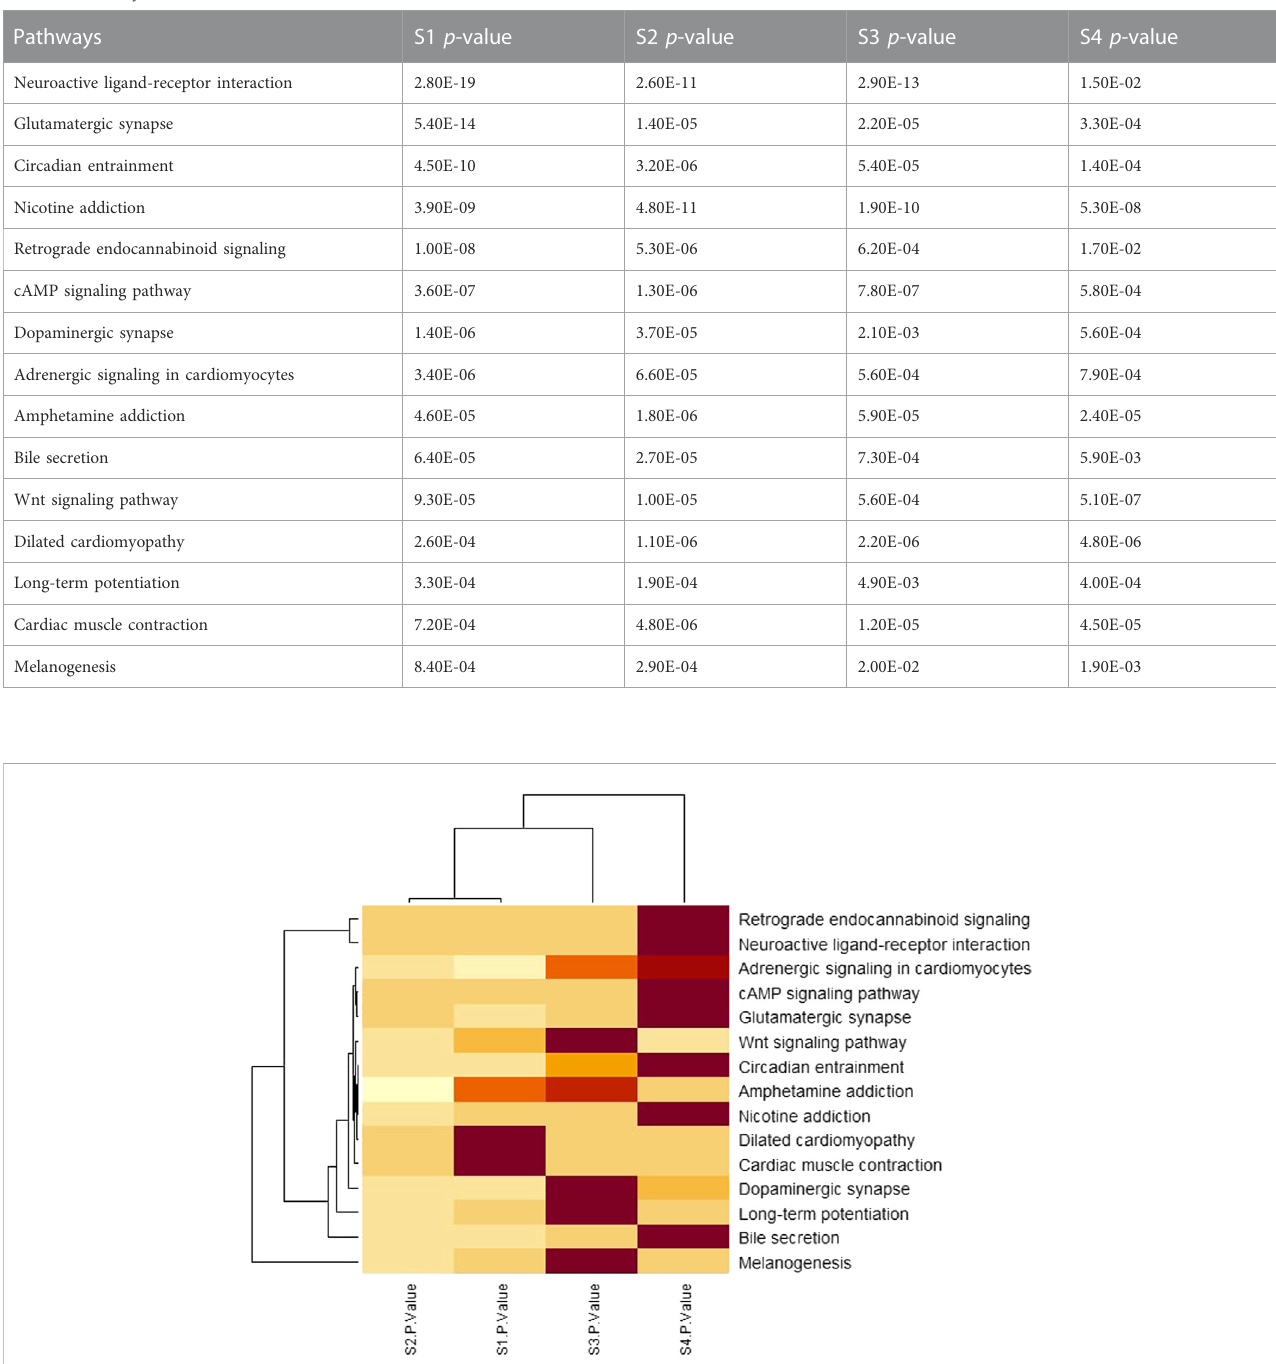
TABLE 3 Pathways table.